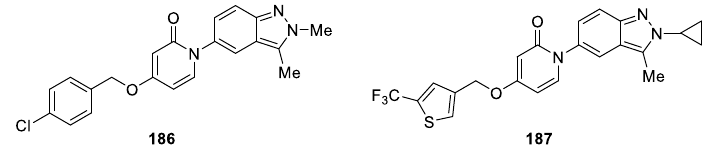
Figure 63. Chemical structures of 1-(2 H -indazole-5-yl)pyridin-2(1 H )-one derivatives 186 and 187 .